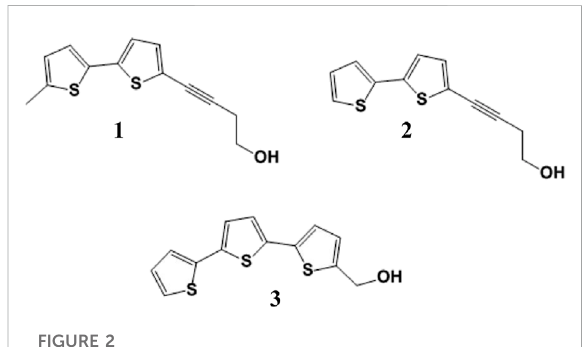
FIGURE 2 Chemical structures of 5 ′ -methyl-[5-(4-hydroxy-1- butynyl)]-2,2 ′ -bithiophene (1), 5-(4-hydroxybut-1-ynyl)-2,2 ′ - bithiophene (2) and α -terthienylmethanol